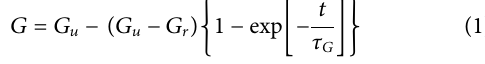
Frontiers in Materials |